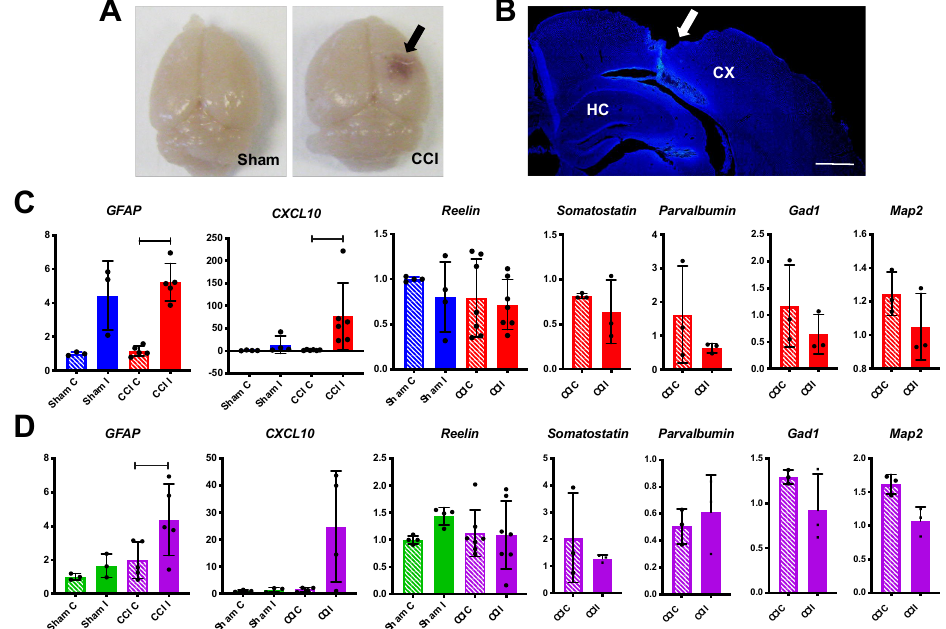
Figure 1. Inflammation but no change in Reelin or other neuron marker expression at 24 h post-controlled cortical impact (CCI). ( A ) Representative images of the whole brain from mice subjected to sham surgery or CCI. The cortical injury is clearly detectable in the ipsilateral side (I) of the CCI mouse (arrow). ( B ) Representative image of a brain section stained with the DAPI nuclear stain, showing extensive cortical damage in the side ipsilateral to the injury (arrow). CX = cerebral cortex; HC = hippocampus; scale bar = 500 m. ( C , D ), RT-qPCR analysis of gene expression in cerebral cortical ( C ) or hippocampal ( D ) samples from sham or CCI groups. The following number of mice were analyzed for each gene: GFAP , CXCL10 , and Reelin ( n = 5–7 CCI, n = 3–4 sham); Somatostatin , Parvalbumin , Gad1 , and Map2 ( n = 3 CCI). Statistical analysis was conducted comparing contralateral (C) to ipsilateral (I) values in each sham or CCI group using paired t -tests (for normally distributed values) or Wilcoxon matched-pair tests (for values that were not normally distributed). Inflammatory markers GFAP and CXCL10 were significantly elevated in cortical CCI I samples. These genes were also elevated in hippocampal CCI I samples, but only GFAP was significantly increased. GFAP was also elevated in cortical sham I samples, although the values did not reach statistical significance. All other genes analyzed were unaffected by CCI or sham surgery. Scatter dot plots show individual data points and the mean values +/- standard deviation (SD). * p < 0.05; ** p < 0.01.